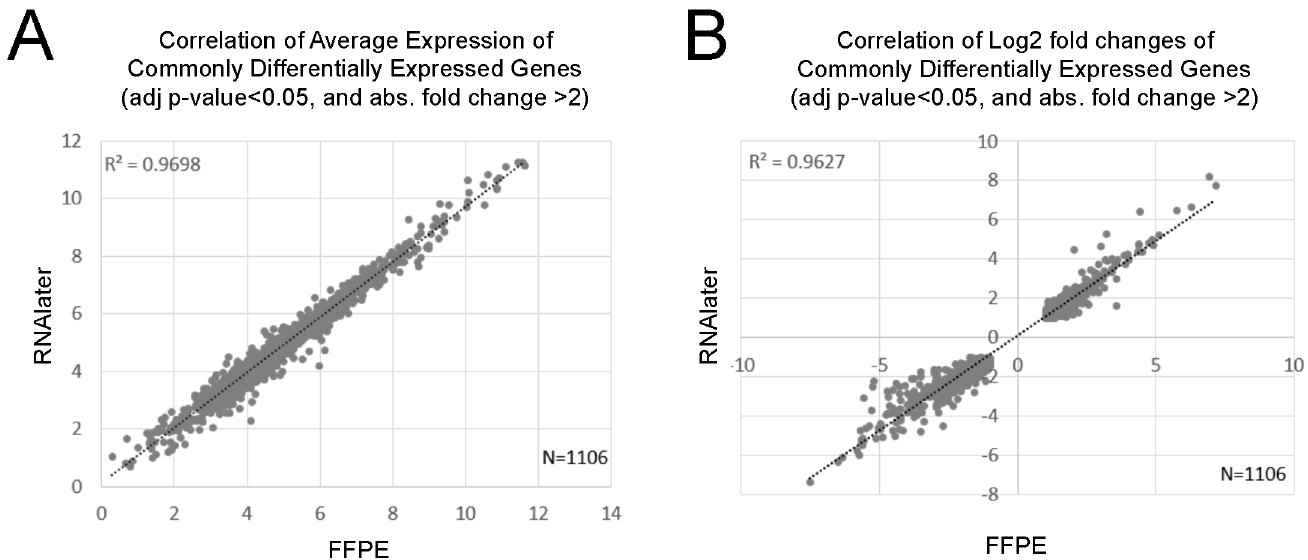
Fig 2. Correlation of gene expression data. The correlation of commonly differentially expressed genes is given with respect to (A) average expression and (B) log2 fold changes.